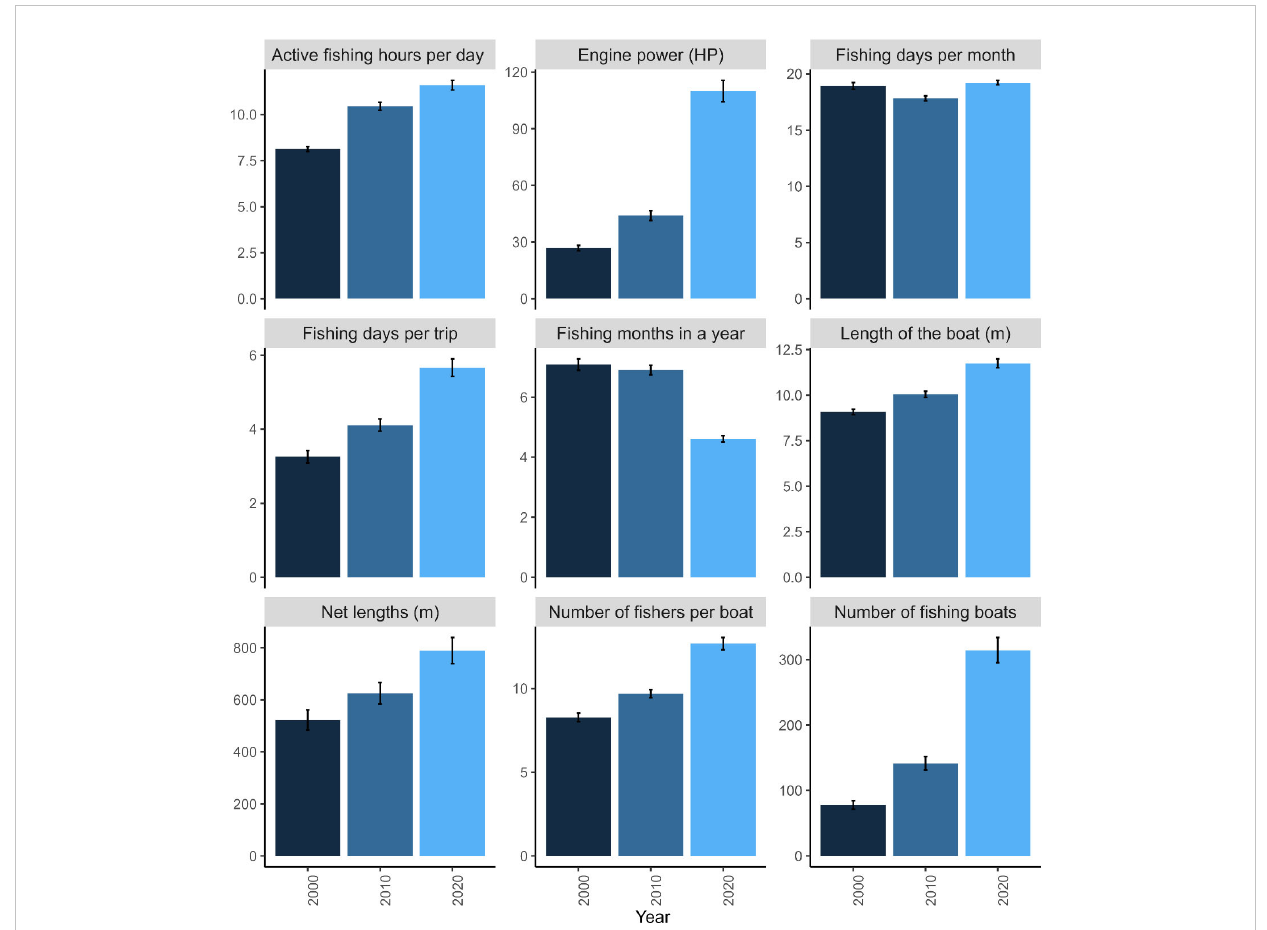
FIGURE 5 Temporal evolution of fi shing effort between 2000 and 2020 in the small-scale marine fi sheries of the Bay of Bengal. Source: Fishers ’ FGD